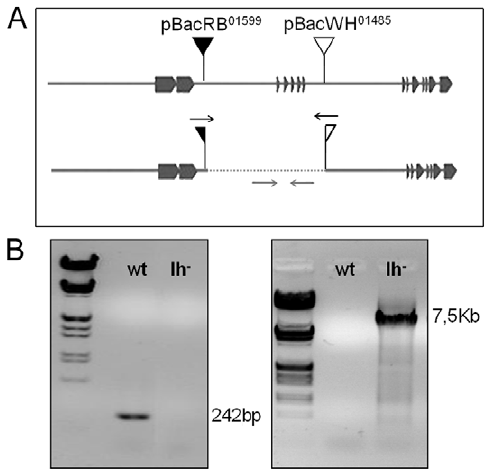
Figure 1. Generation of the DmIh null mutant. (A) Diagram of the DmIh gene showing the position of the two piggyBac transposon insertion sites. The dotted line at the bottom scheme corresponds to the deleted region upon recombination. Black arrows indicate the position of the primers used to amplify the newly formed piggyBac element (amplicon size 7.5 Kb). Gray arrows indicate the position of the primers inside the deleted region (amplicon size 242 bp). (B) PCR results show lack of amplification of the presumptive deleted region in the Ih 2 line, further confirmed with the positive amplification of the newly formed piggyBac